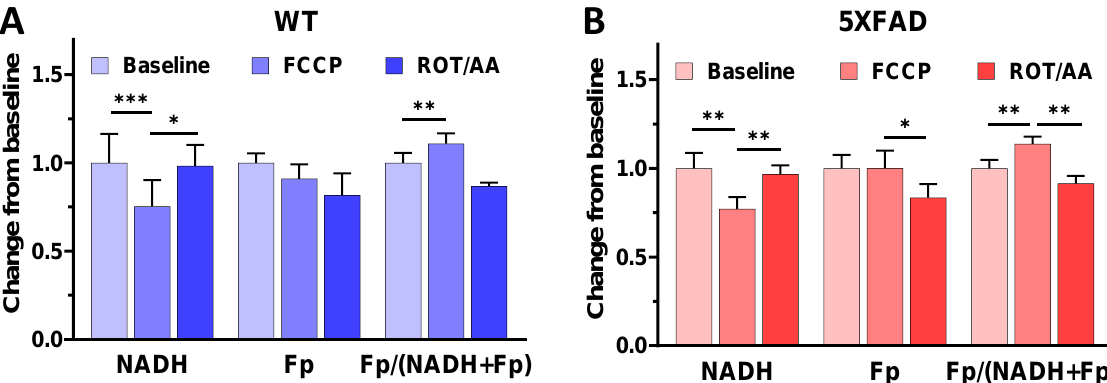
Figure 2. Redox responses of ~1 mm thick hippocampal slices from 2-month-old wild type ( A ) and 5XFAD ( B ) mice to the metabolic modulator FCCP followed by rotenone + antimycin A (ROT/AA). Bars represent normalized mean ± SE (before and after drug administration for the same field of view, n = 5 slices/genotype). *, p < 0.05; **, p < 0.01; ***, p < 0.001 (paired t -test).